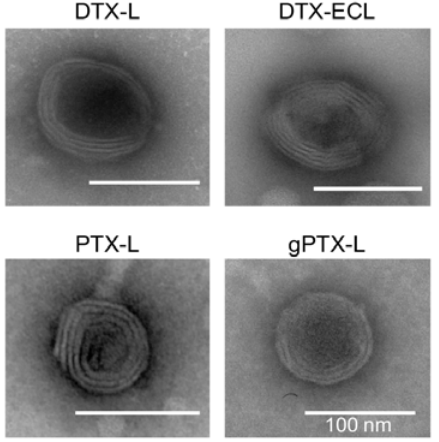
Figure 1. Encapsulation efficiency (EE) and loading efficiency (LE) of taxanes encapsulated into liposomes under different drug to lipid ratios. Liposomes composed of hydrogenated soybean phosphatidylcholine (HSPC), Chol, 1,2-distearoyl- sn -glycerol-3-phosphoethanolamine- N -[methoxy (polyethylene glycol)-2000] (mPEG-DSPE) and taxanes at the molar ratio of 60:40:5: x , x were prepared using CEP (20:15:65 volume%). ( A ) DTX-L; ( B ) PTX-L; ( C ) gPTX-L. Data are shown as mean ± S.D. where N = 4. * p < 0.05.